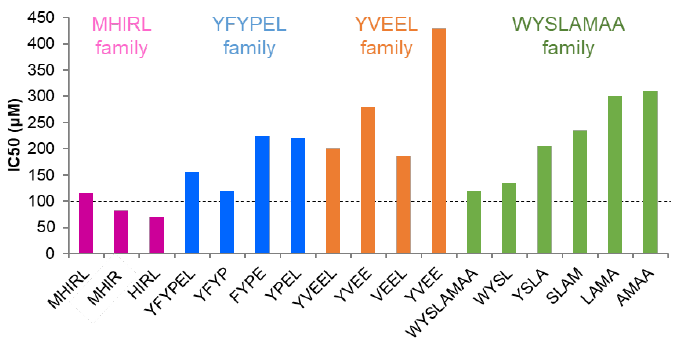
Figure 1. Half-maximal inhibitory concentration (IC 50 ) values of milk-derived peptides and their fragments. The dotted line indicates tetrapeptides under IC 50 100 µ M. Conditions: various concentrations of peptides, L-DOPA (2.5 mM) and mushroom tyrosinase (100 µ g / mL, 428 U / mL) were incubated at 25 ◦ C for 10 min.